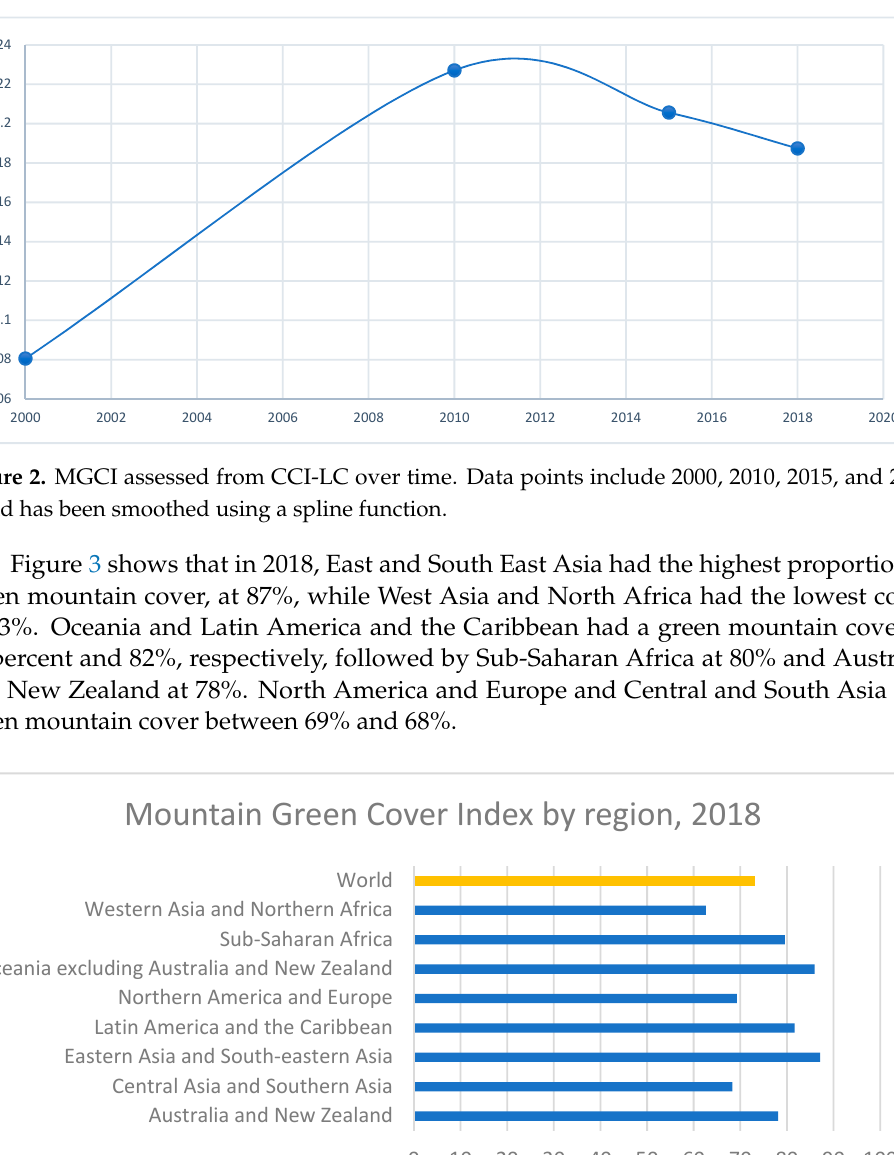
mental and Economic Accounting (SEEA).